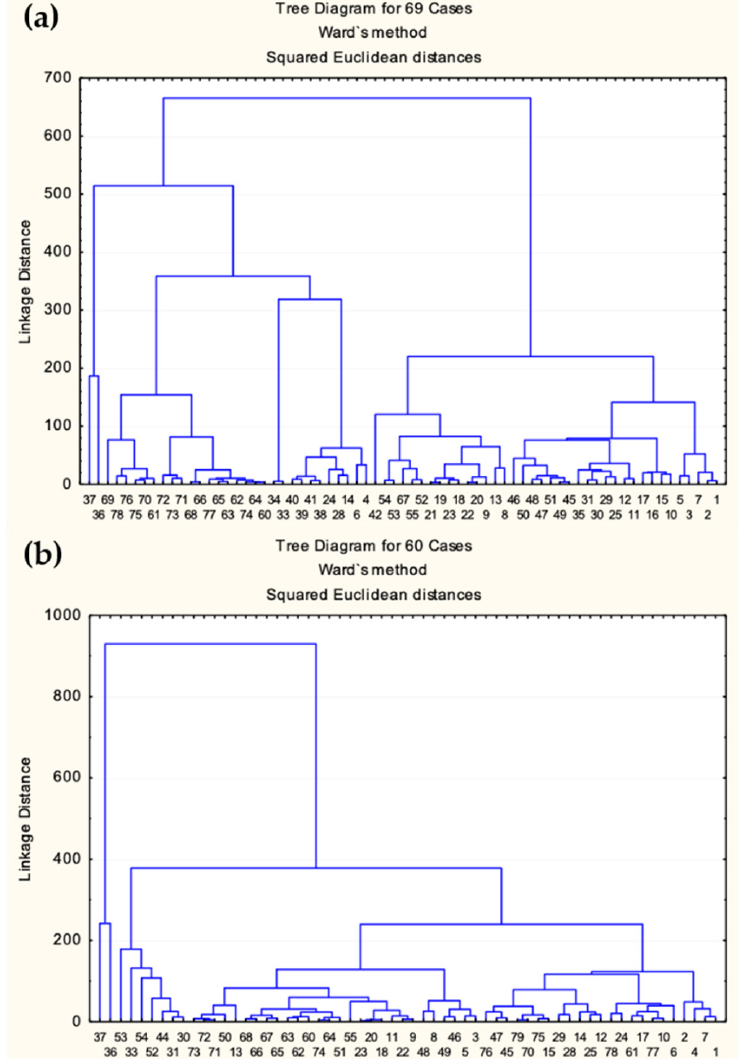
Figure 3. Dendrograms generated by hierarchical cluster analysis show the groups formed by the different sampling sites during ( a ) dry and ( b ) rainy seasons—groups 1 and 2, subgroups a, b, c, and d. There is no statistical evidence of a direct influence of the “Los Azufres” geothermic field on the chemical composition of the nearest sites for water supply, especially those in SPJ and ZIN.